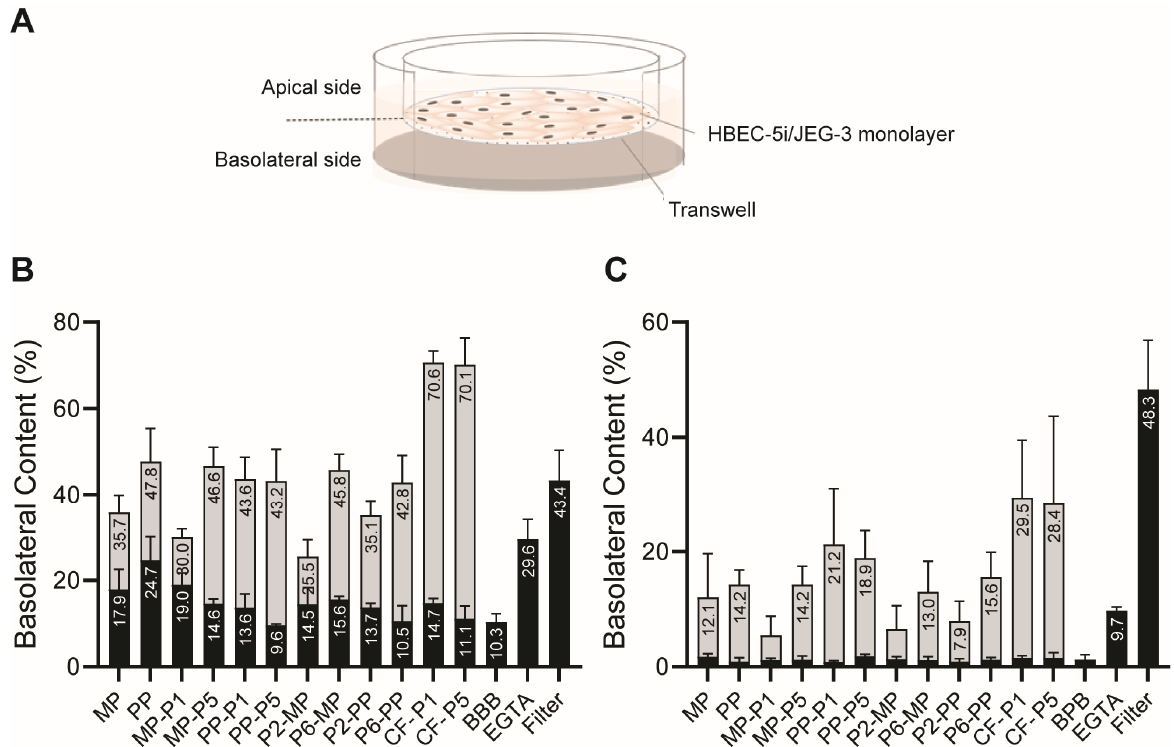
Figure 1. In vitro PPC translocation. ( A ) Schematic representation of the BBB and BPB model transwell system. ( B , C ) in vitro BBB and BPB translocation measurements. PPC translocation values are depicted in grey, while FD4 permeability values post-translocation are in black (BBB and BPB—only cells, EGTA—tight junctions disruption control, Filter—no cells).